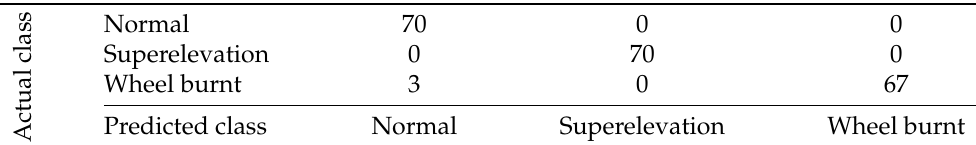
Table 7. Confusion matrix of LSTM 8.5 s split, un-augmented training dataset and un-augmented test dataset.